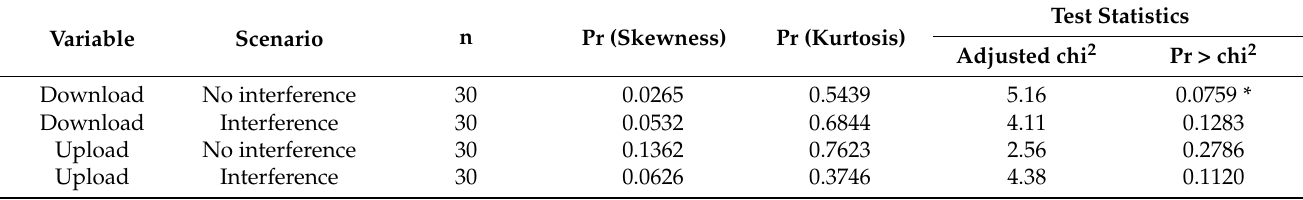
Table 4. Levene’s test of the homogeneity of variance in download measurements.